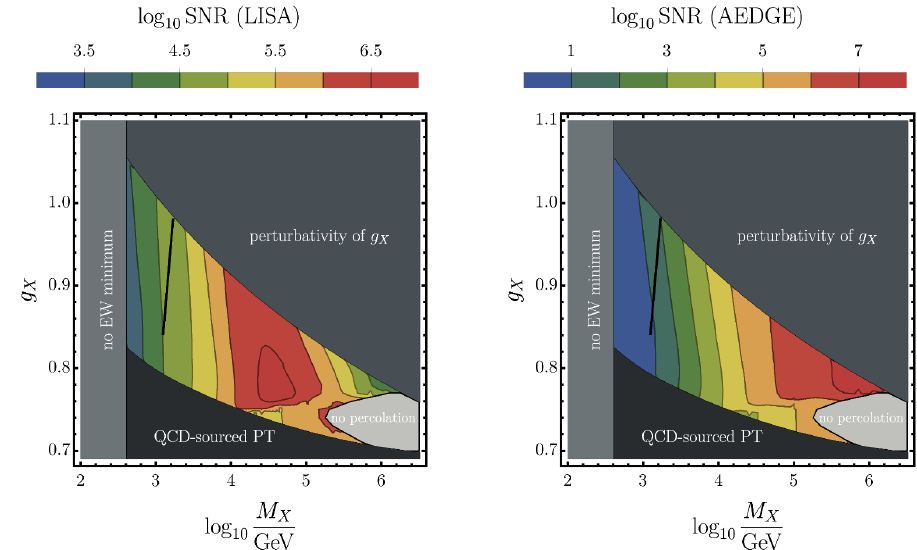
Figure 17 . Results for the signal-to-noise ratio for LISA (left panel) and AEDGE (right panel) for the predicted GW signal. The black line corresponds to the points that reproduce the measured DM relic abundance and also evade the DM direct detection experimental